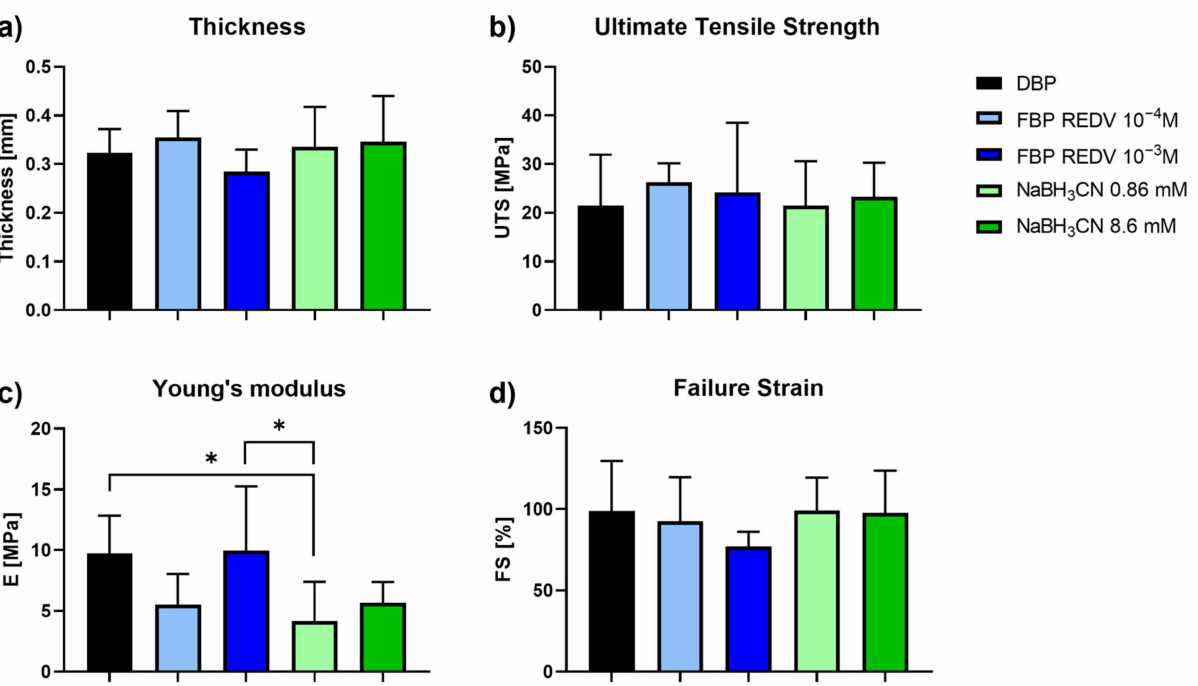
Figure 5. Mechanical tests performed on functionalized and not functionalized samples. ( a ) Evalua- tion of DBP samples’ thickness; ( b ) Ultimate Tensile Strength; ( c ) Young’s modulus; and ( d ) Failure Strain values obtained on DBP and functionalized DBP samples. * p -value <